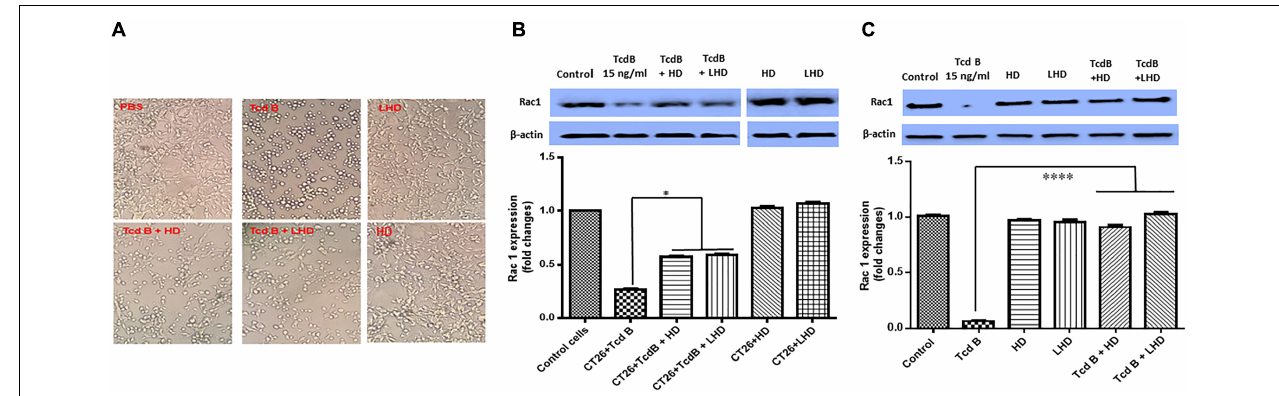
FIGURE 5 | LHD inhibits cytotoxicity of TcdB. (A) LHD inhibits TcdB-induced cell rounding. CT26 cells in 12-well plates were exposed to HD or LHD at 750 ng/ml (50 times of TcdB concentration) or nothing for 1 h, followed by exposure to TcdB at 15 ng/ml for 5 h. (B) Western-blot analysis of non-glucosylated Rac1 in CT26 cells treated with TcdB in the presence or absence of LHD or HD. TcdB glucosylates Rac1 in cells, serving as a readout for toxin cytotoxicity. Up panel shows one blot being cut into two separate blots to remove extra sample lanes. i.e., all bands were from the same blot. Quantitation of Rac1 levels in Western-blot was shown in low panel ( ∗ p < 0.05). (C) CT26 cells were lysed, and the cytosolic fraction was exposed to TcdB (15 ng/ml) with or without HD at 750 ng/ml (50 times of TcdB concentration) or LHD at 1500 ng/ml (same molecular concentration as HD) or nothing for 1 h followed by Western Blot analysis using a monoclonal antibody that only recognizes non-glucosylated Rac1. β -actin was used as an equal loading control. Quantitation of Rac1 levels in Western-blot was shown in low panel ( ∗∗∗∗ p < 0.0001).